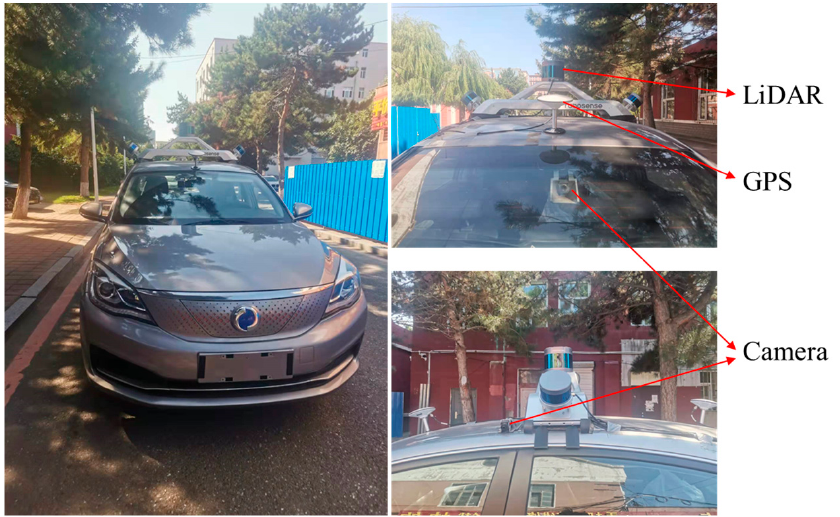
Figure 19. Vehicle for recording mapping data, equipped with RTK-GPS, LiDAR, and cameras.